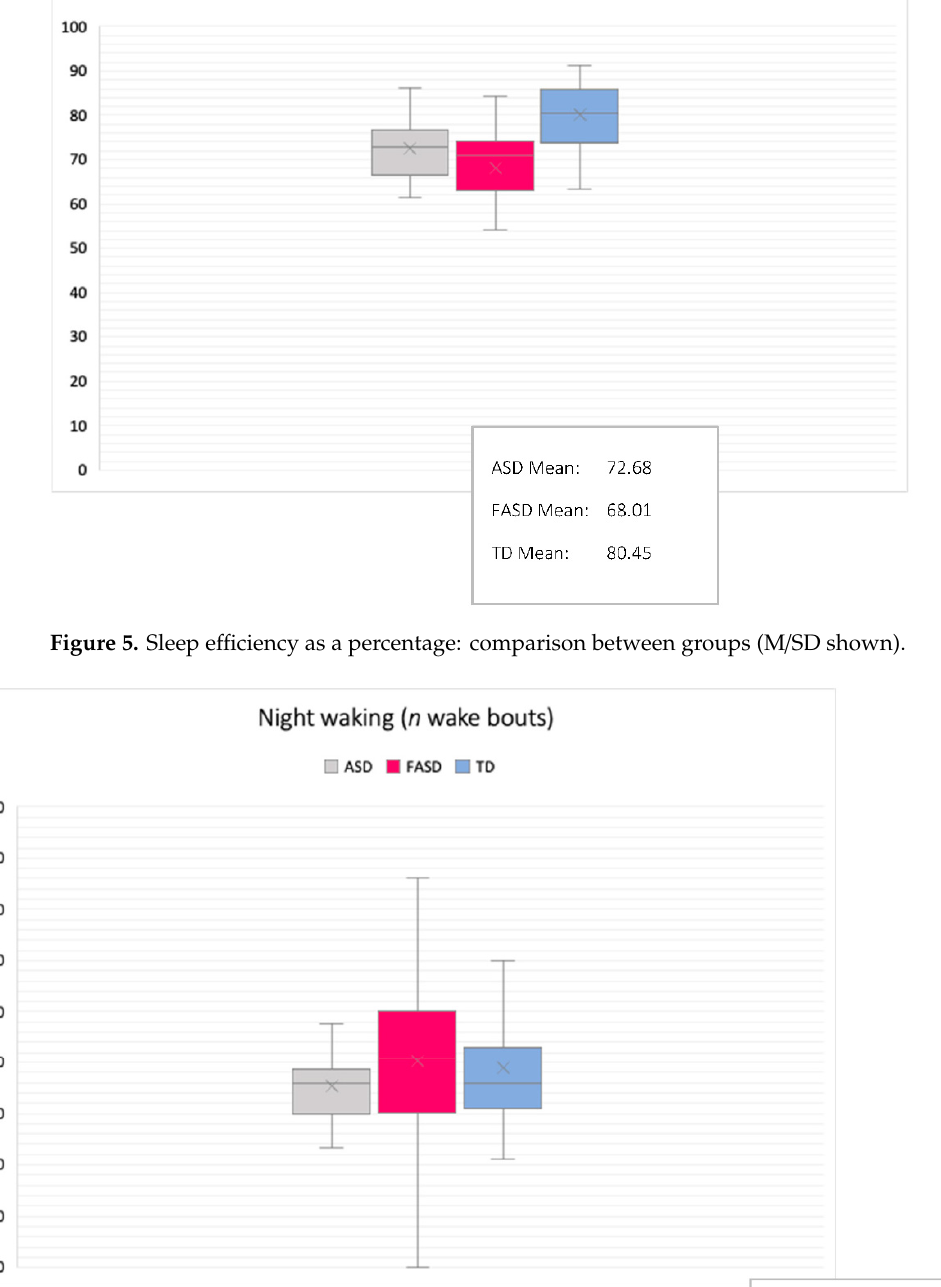
Figure 4. Sleep duration (hh:mm): comparison between groups (M/SD shown).